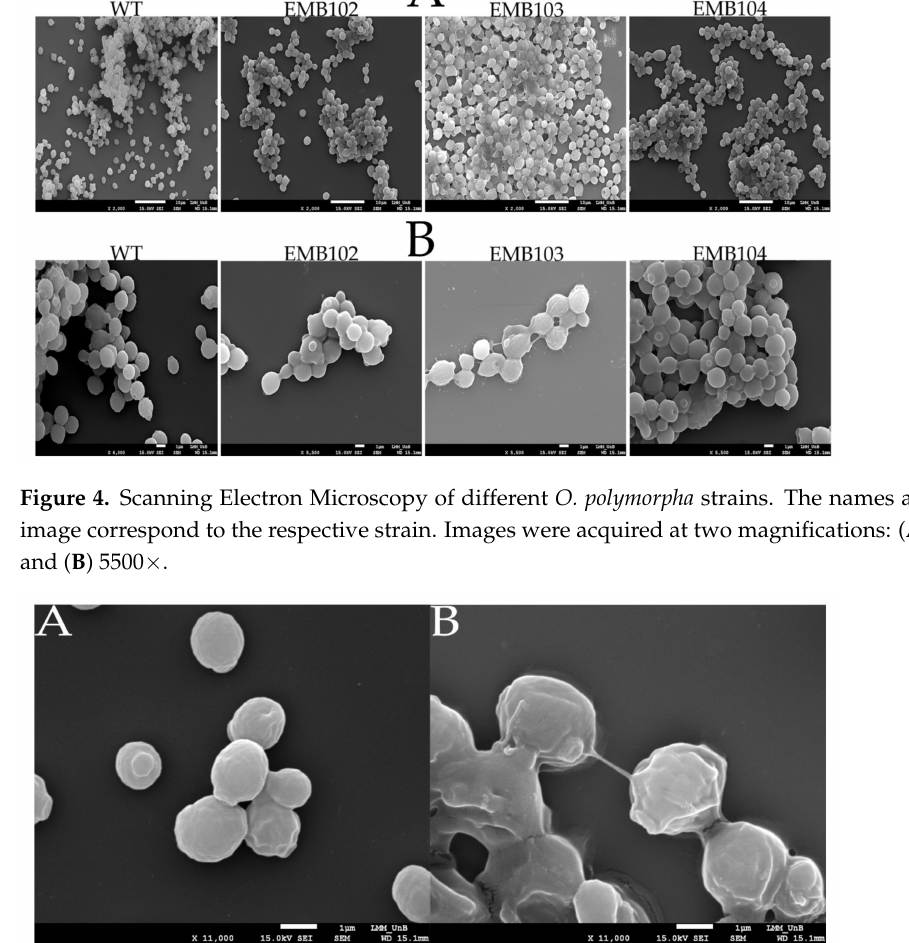
Figure 5. Scanning Electron Microscopy of Wild Type (WT) ( A ) and EMB103 ( B ) in the magnitude of 11,000 ×